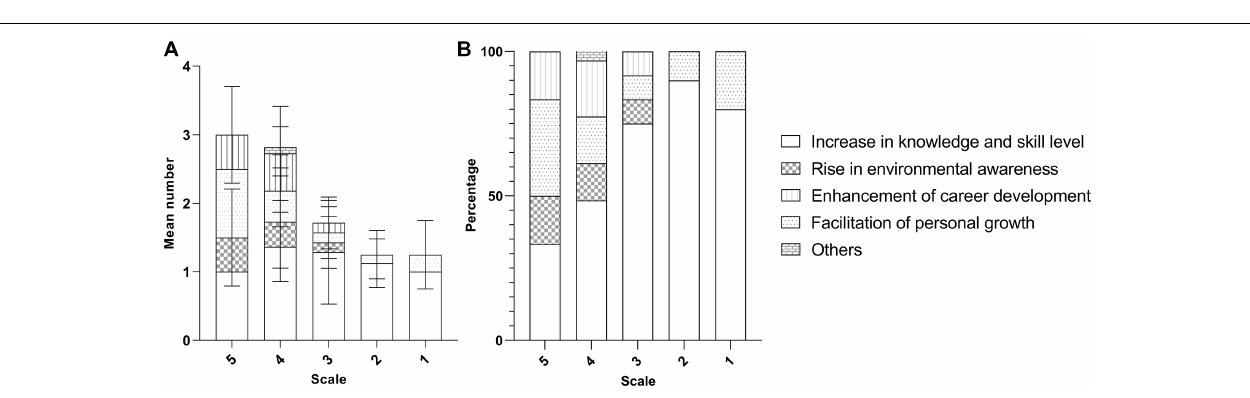
FIGURE 9 | Mean number (A) and the corresponding percentage (B) of outcomes ( ± SD) mentioned by the respondents to the online questionnaire from the different levels of self-perceived